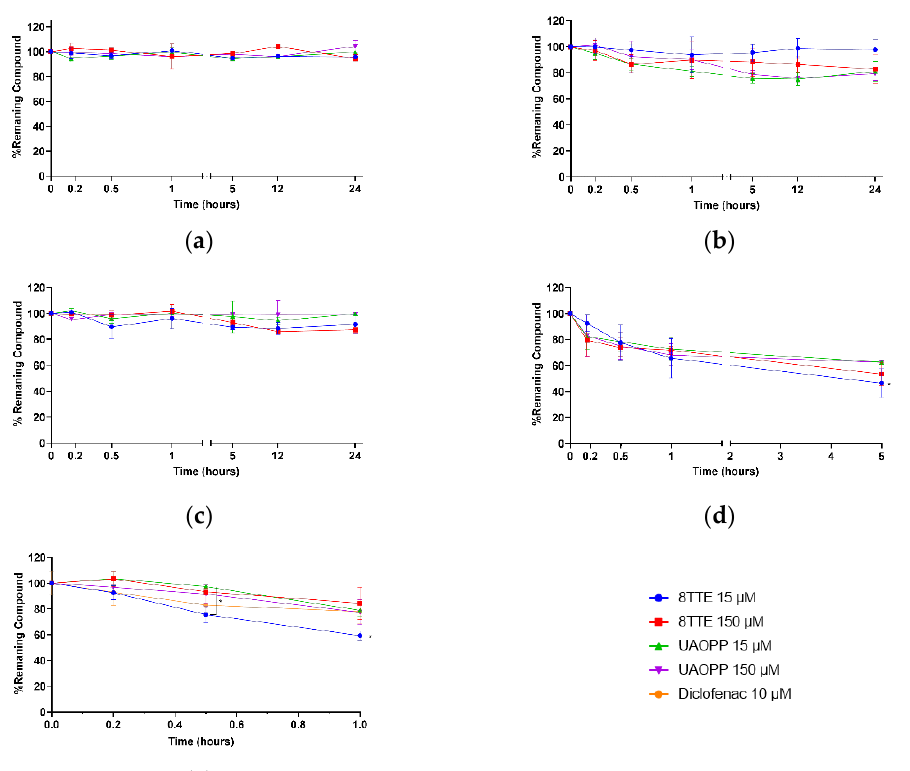
Figure 1. 8TTE, UA-3- O -PP and positive controls stability profiles in different simulated physiologic conditions at two different concentrations (15 µM – 150 µM): ( a ) water; ( b ) phosphate Buffer 0.1 M pH 7.4; ( c ) entire plasma; ( d ) HCl pH 1.2; ( e ) pooled male mouse microsomes. Non-parametric ANOVA analysis: * p < 0.05 (Kruskal – Wallis and Dunn’s tests